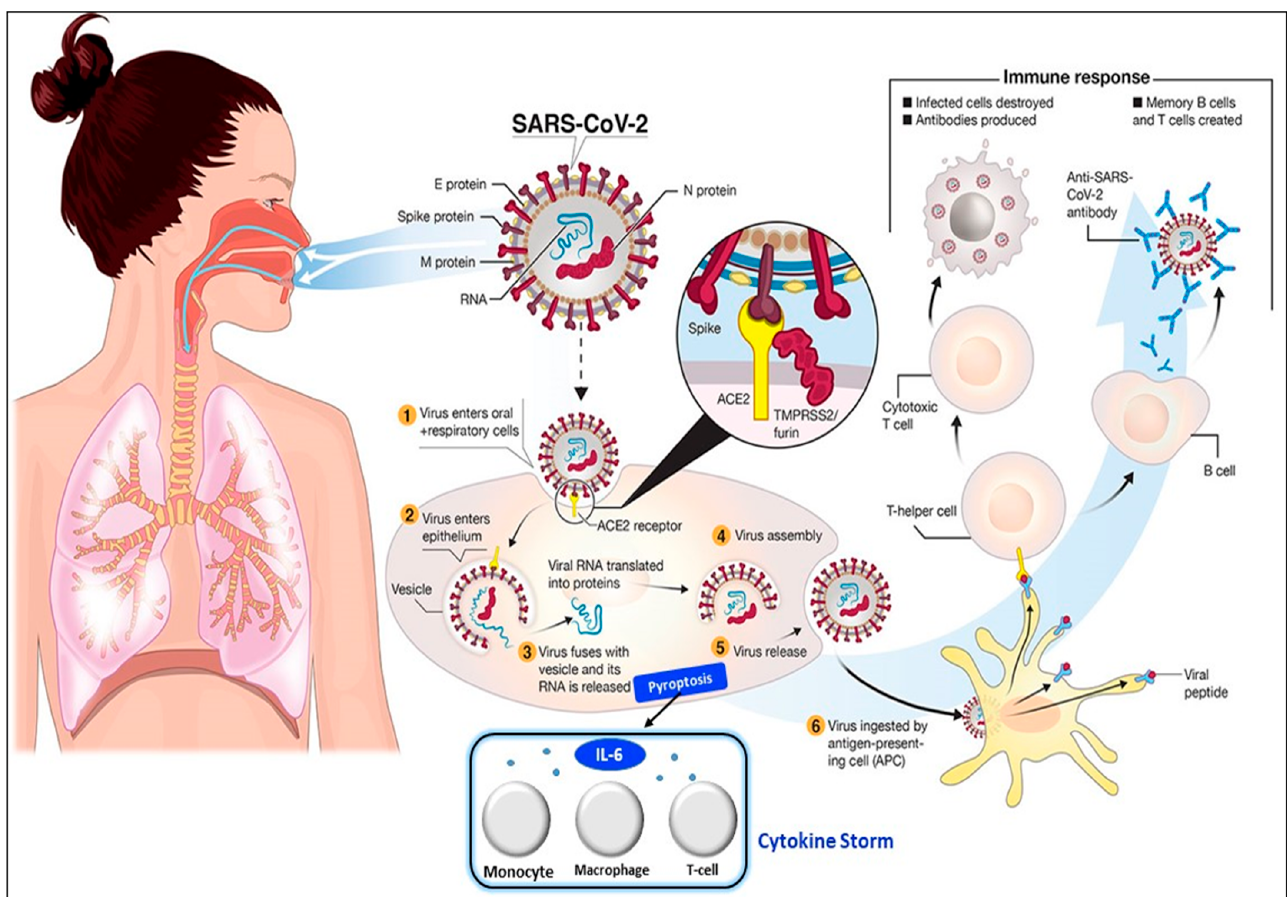
Figure 2. Pathophysiology of the SARS-CoV-2 virus. SARS-CoV-2 virus invasion in the human body undergoes the following processes: ( 1 ) virus adhesion with ACE2 receptor; ( 2 ) virus entry into cells; ( 3 ) release of viral RNA and replication; ( 4 ) assembly of new viral content, which causes the pyroptosis of the host cell and induces the secretion of pro-inflammatory cytokines and chemokines. These processes attract monocytes, macrophages, and T cells and result in an inflammatory response. ( 5 ) Release of virus; ( 6 ) antigen-presenting cells engulf viral particles and activate T helper cells. This activates an adaptive immune response that stimulates B cells to produce antibodies against the virus and T cytotoxic cells to recognize and destroy infected cells. Hence, the accumulation of immune cells at infection sites after an excessive pro-inflammatory stimulus primarily begins with the release of IL-6, which induces the cytokine storm. Reprinted from [27] and modified with the insertion of the cytokine storm part.